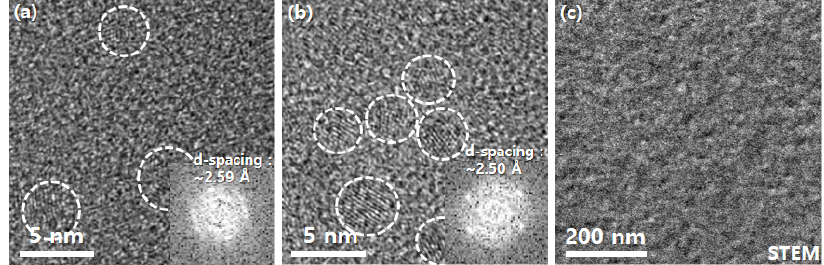
Figure 4. TEM and STEM images of SiC nanoparticles with additional hot-wire biases of ( a ) 0 V, ( b ) + 50 V and ( c ) − 50